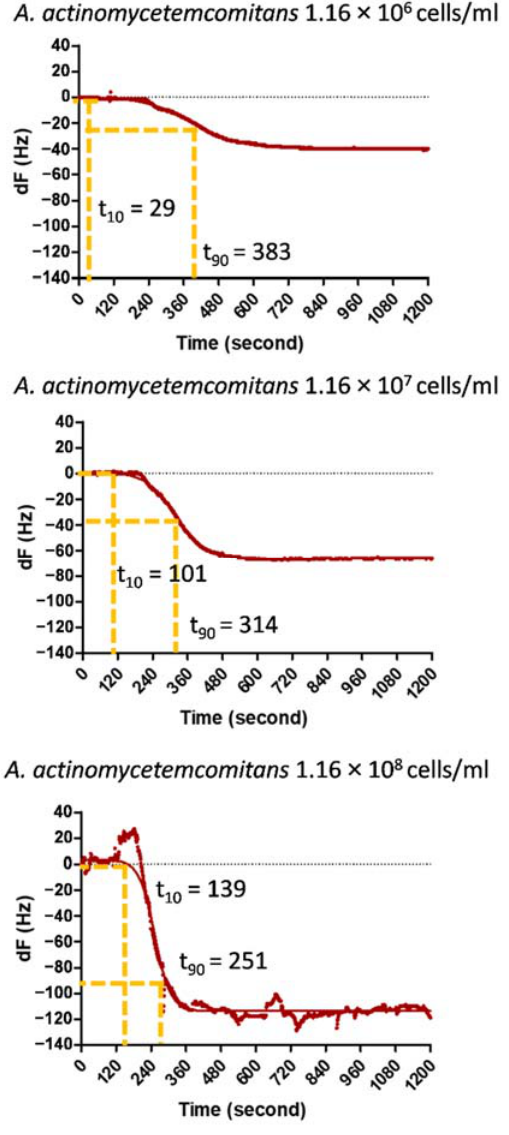
Figure 7. The t 10 and t 90 obtained from the fitted curve of the measurements are indicated by the yellow lines.